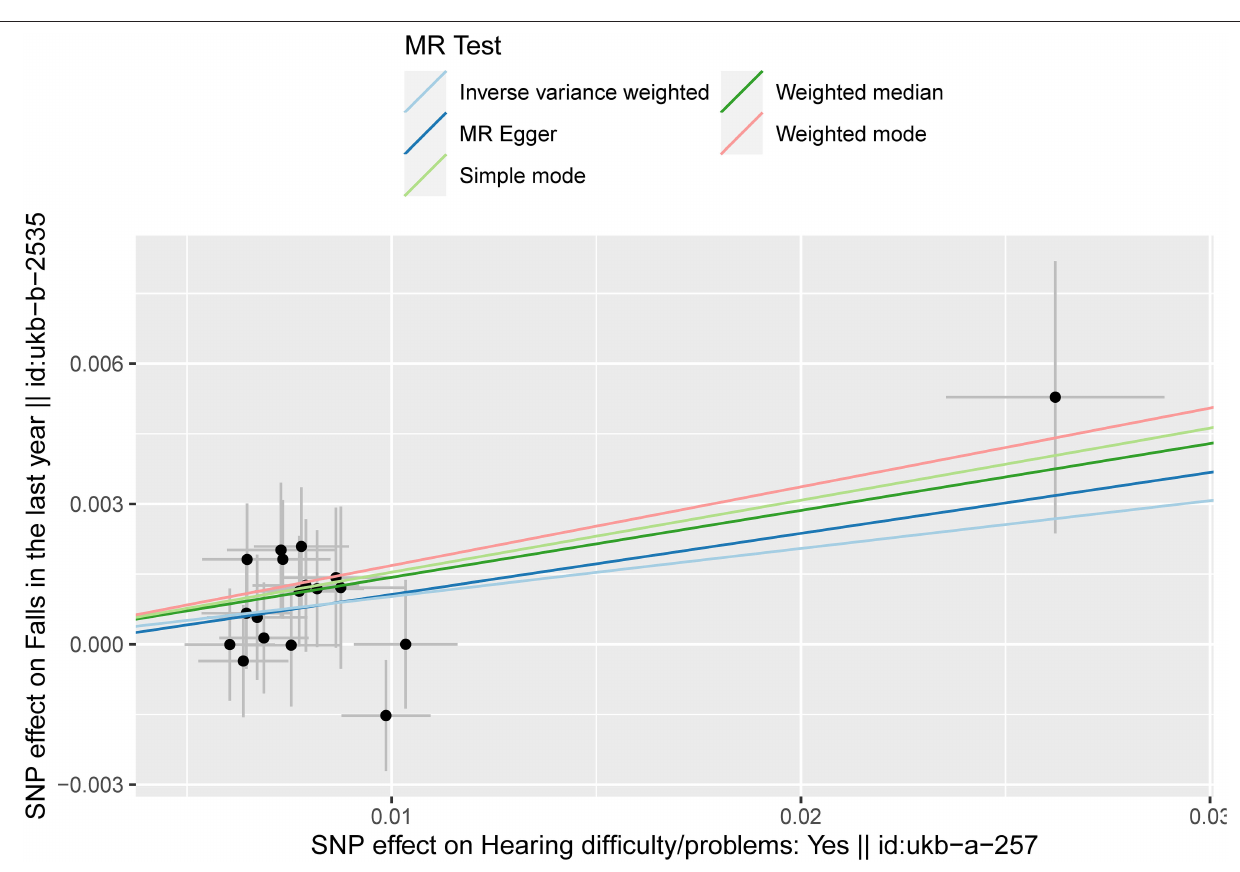
FIGURE 2 | Scatter plot of the effects of genetic variants on the HI and falls. The slopes of the solid lines denote the magnitudes of the associations estimated from the MR analyses. HI, hearing impairment; MR, Mendelian randomization; SNP, single-nucleotide